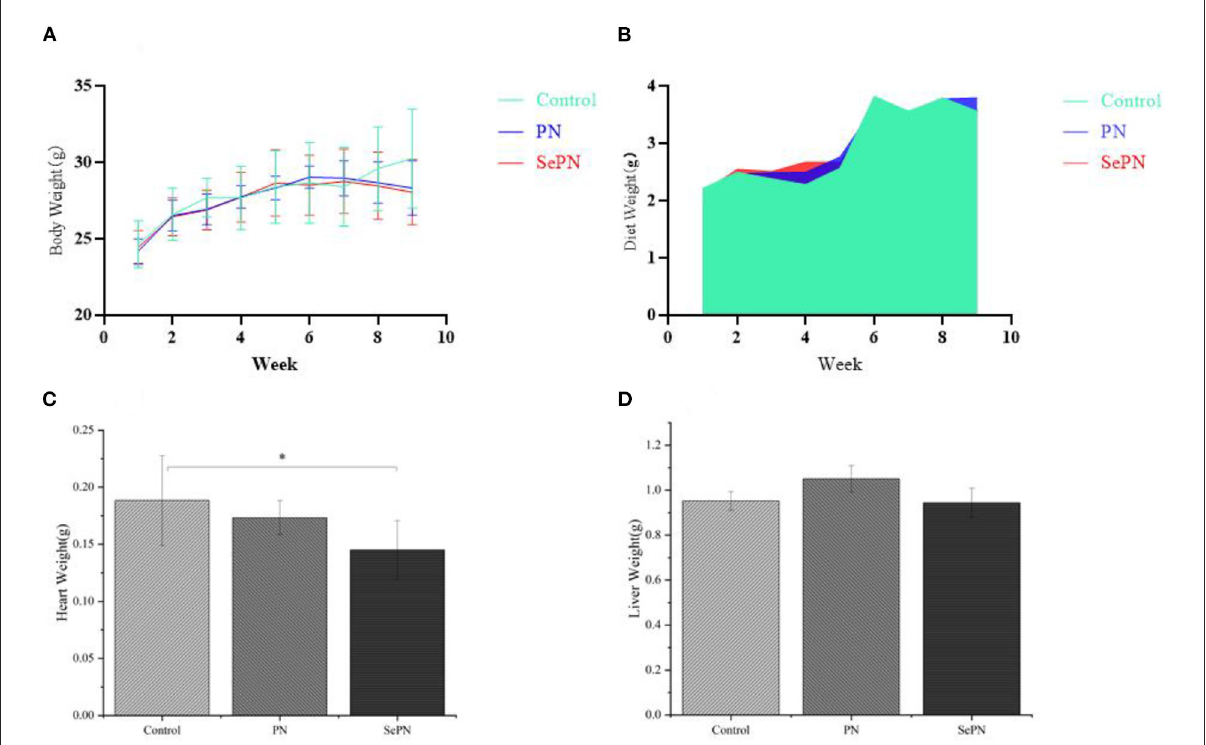
FIGURE1 Body weight, diet and organ weight of mice. (A) . Body weight after 9 weeks of feeding high-fat diet (Control), Panax notoginseng (PN), and selenium-rich Panax notoginseng (SePN). (B) . Dietary intake within 9 weeks. (C,D) . Liver and heart weight after 9 weeks of feeding PN/SePN. Data are expressed as the mean ± SD. * P < 0.05 compared with the control group ( n = 9).